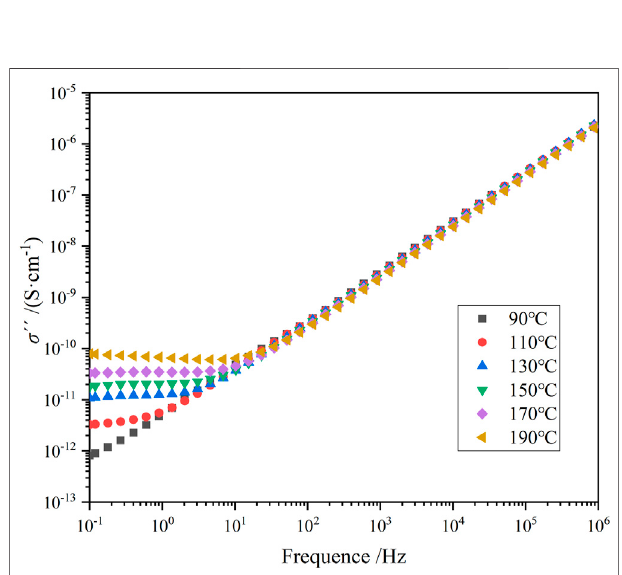
FIGURE 9 | Variation of imaginary part of complex AC conductivity with frequency for 5% HTBN samples at different temperatures.